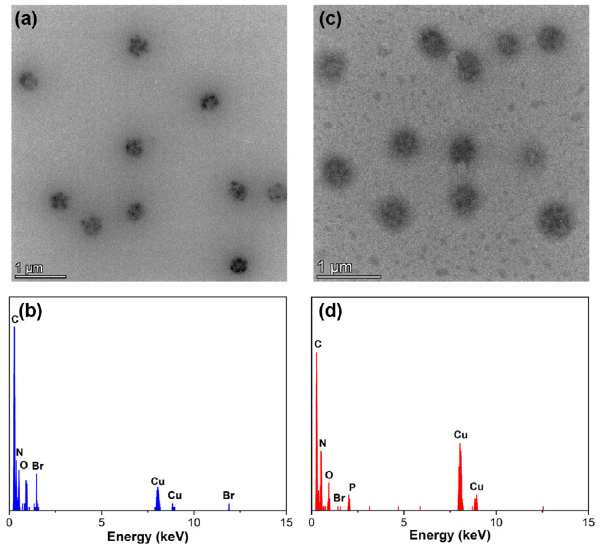
Fig. 3 TEM images and corresponding EDXS of (a, b) MGs-Br and (c, d) MBs-g-MGs.